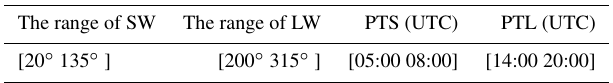
Figure 2. Hourly average of wind angle in a diurnal period (HAWADP) of the local wind. Table 1. Summary of information for the verification of OE-SLB at Brisbane